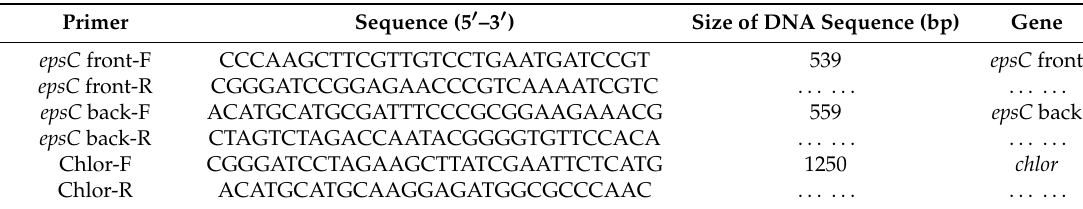
Table 1. Primers used in this